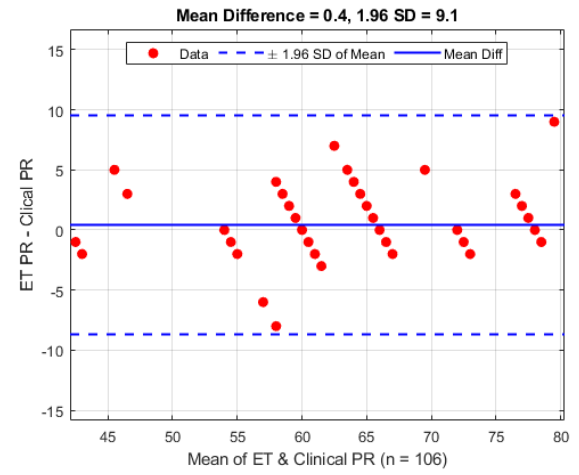
Figure 10. Bland–Altman analysis of pulse rate from the ET sensor vs. the clinical monitor.